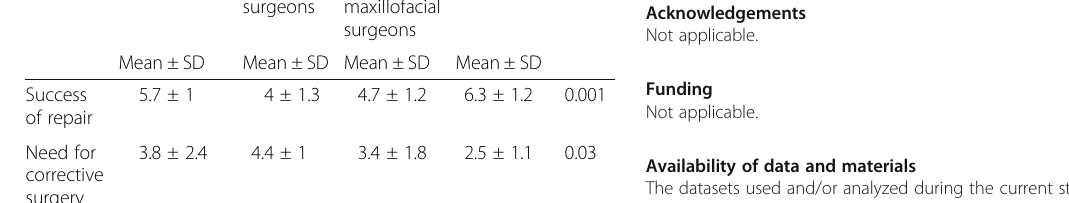
Table 4 Perception of participants towards success of repair and the need for corrective surgery Feature Orthodontists Plastic